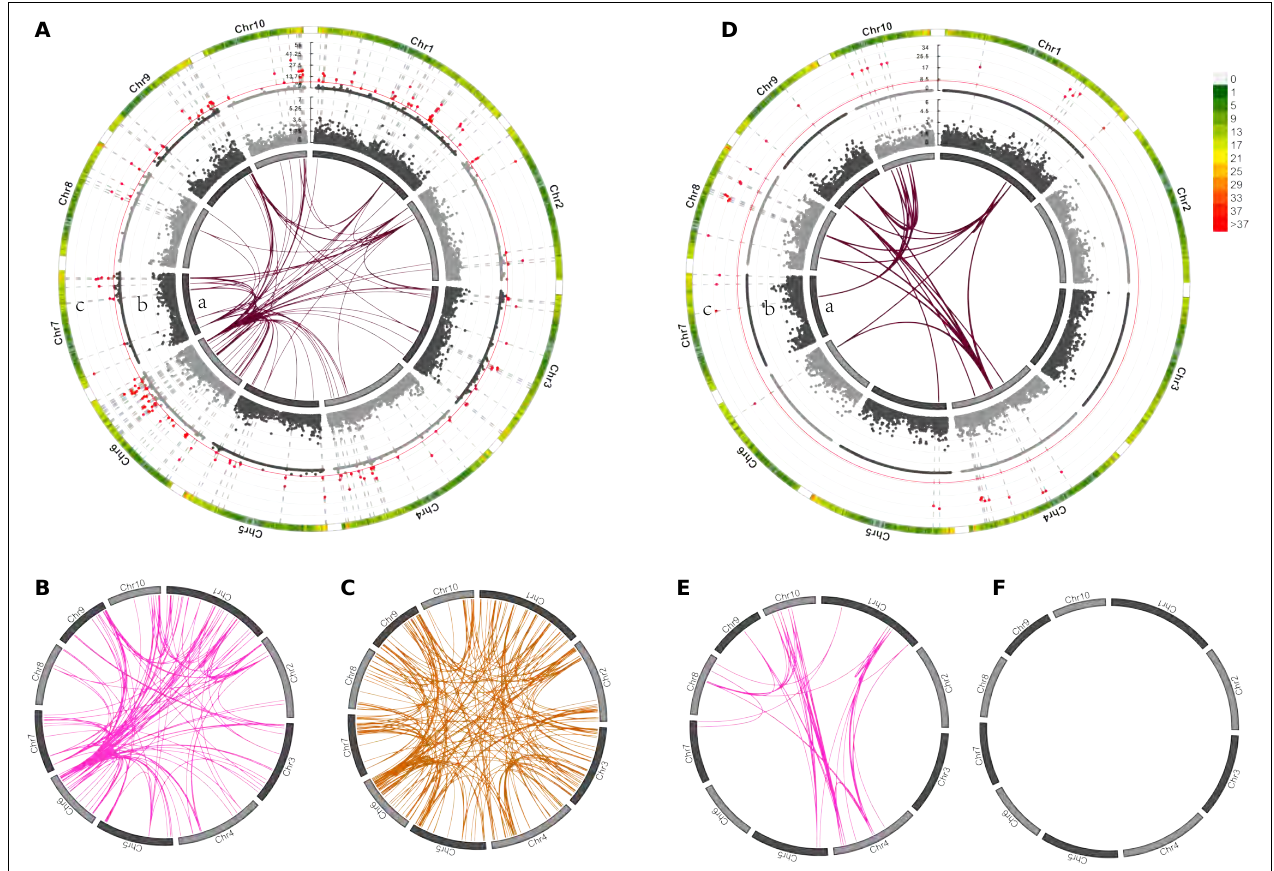
FIGURE 6 | The different mid-parent heterosis genetic effects for days to silking (DTS) in temperate by tropical (A–C) and temperate by temperate (D–F) hybrids. (A–F) In the inner circle, 10 chromosomes are expressed in the form of bars. Gray connector lines indicate the genetic map locations of the SNPs. The colored links within the circle indicate obvious digenic epistatic effects, including additive-by-additive effects [ (A) a, (D) a], additive-by-dominance effects (B,E) , as well as dominance-by-dominance effects (C,F) . Manhattan plots for the heterotic effects [ (A) c, (D) c] and the dominance effects [ (A) b, (D) b] from genome wide association mapping. Red lines indicate the threshold of significance. The different bar colors denote marker density, with one bar representing a window size of 1